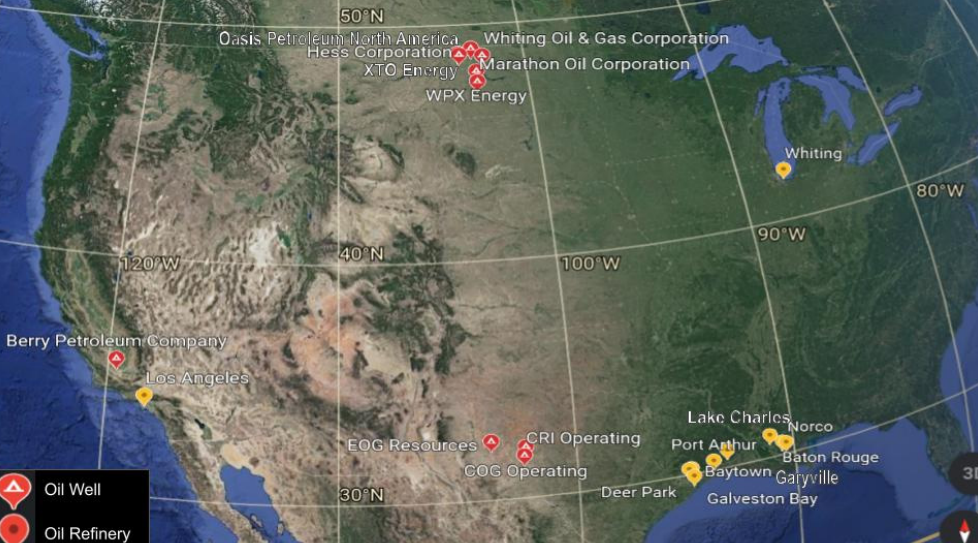
Figure 13. Top CO 2 Bottlenecks of the Oil Industry for Resource Extraction and End-use. Energies 2020 , 13 , x FOR PEER REVIEW